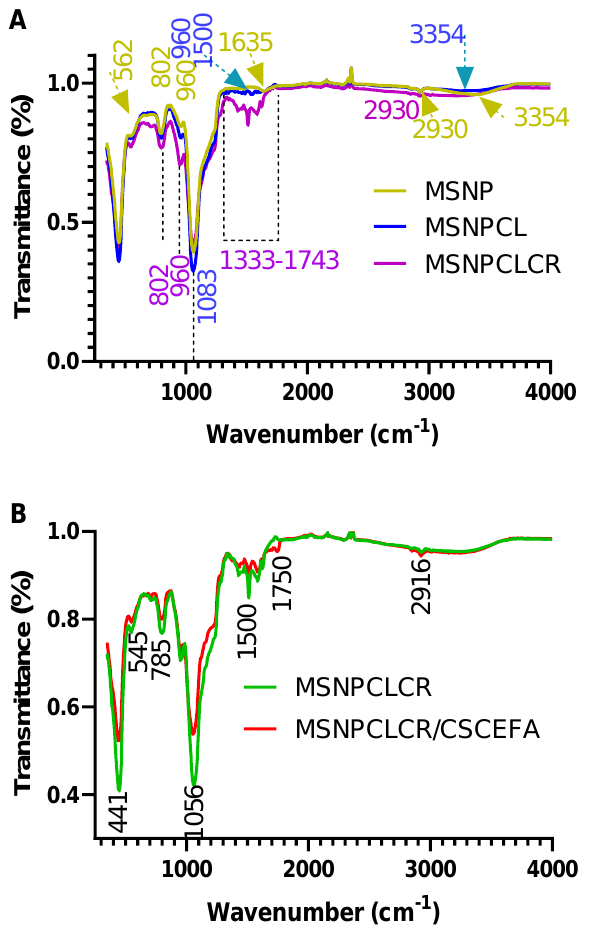
Figure 4. FTIR–ATR spectra of the materials prepared at all stages: MSNP, nanoformulations before and after CS–CE–FA complex coating. ( A ) nanoformulations before coating, and ( B ) MSNPCLCR before coating compared with MSNPCLCR/CSCEFA after coating.